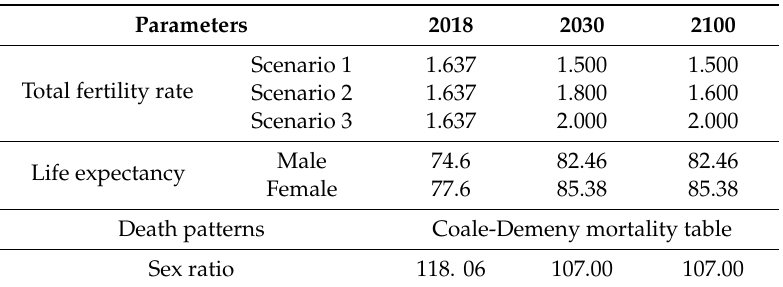
Table 1. Input parameters of in-scenario